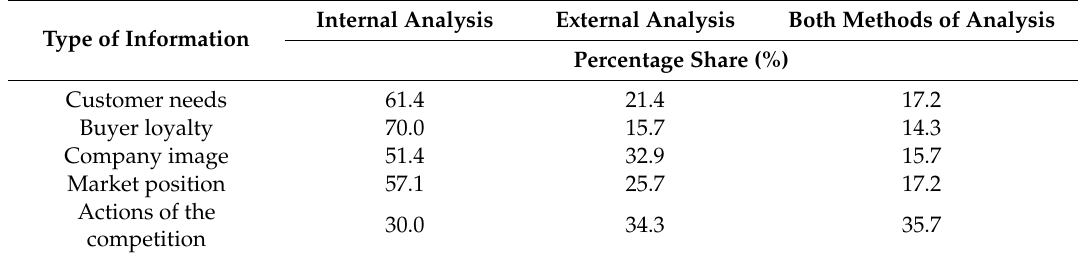
Table 3. The type of information obtained by the company (n =